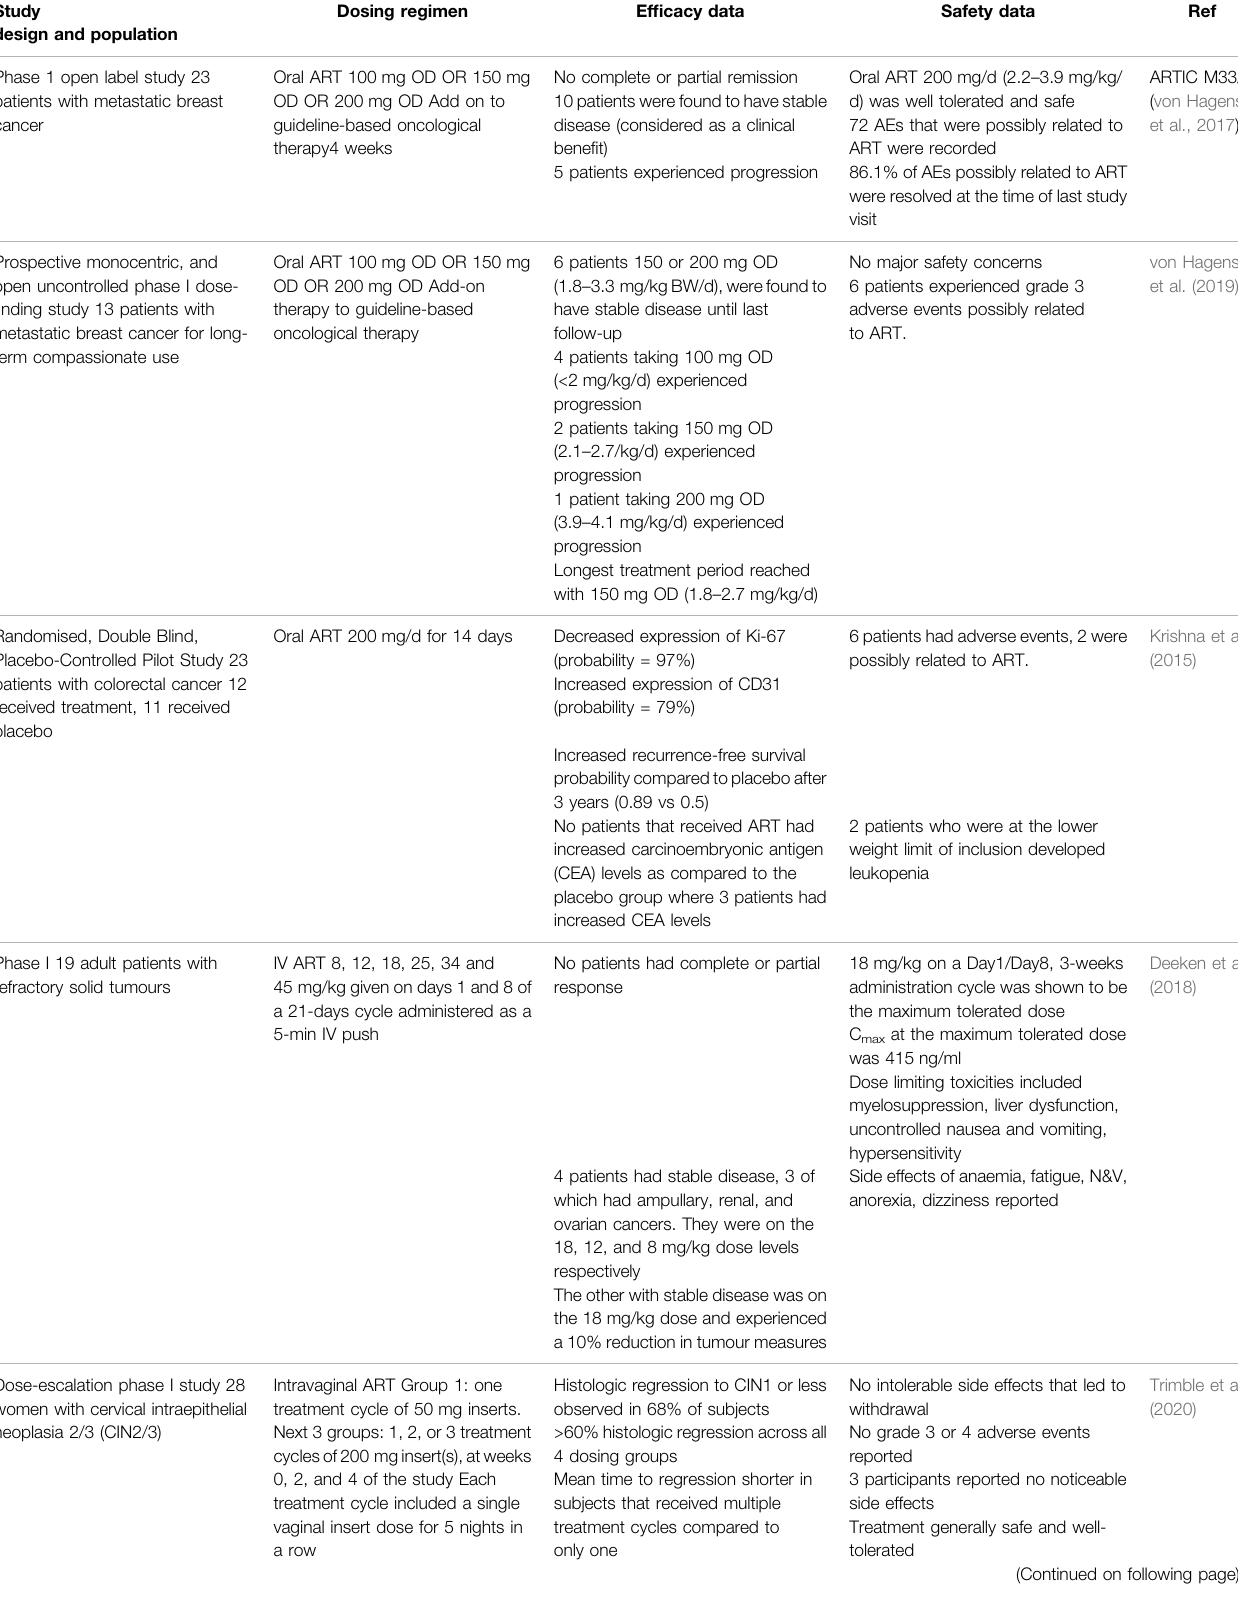
TABLE 3 | Human clinical trials of